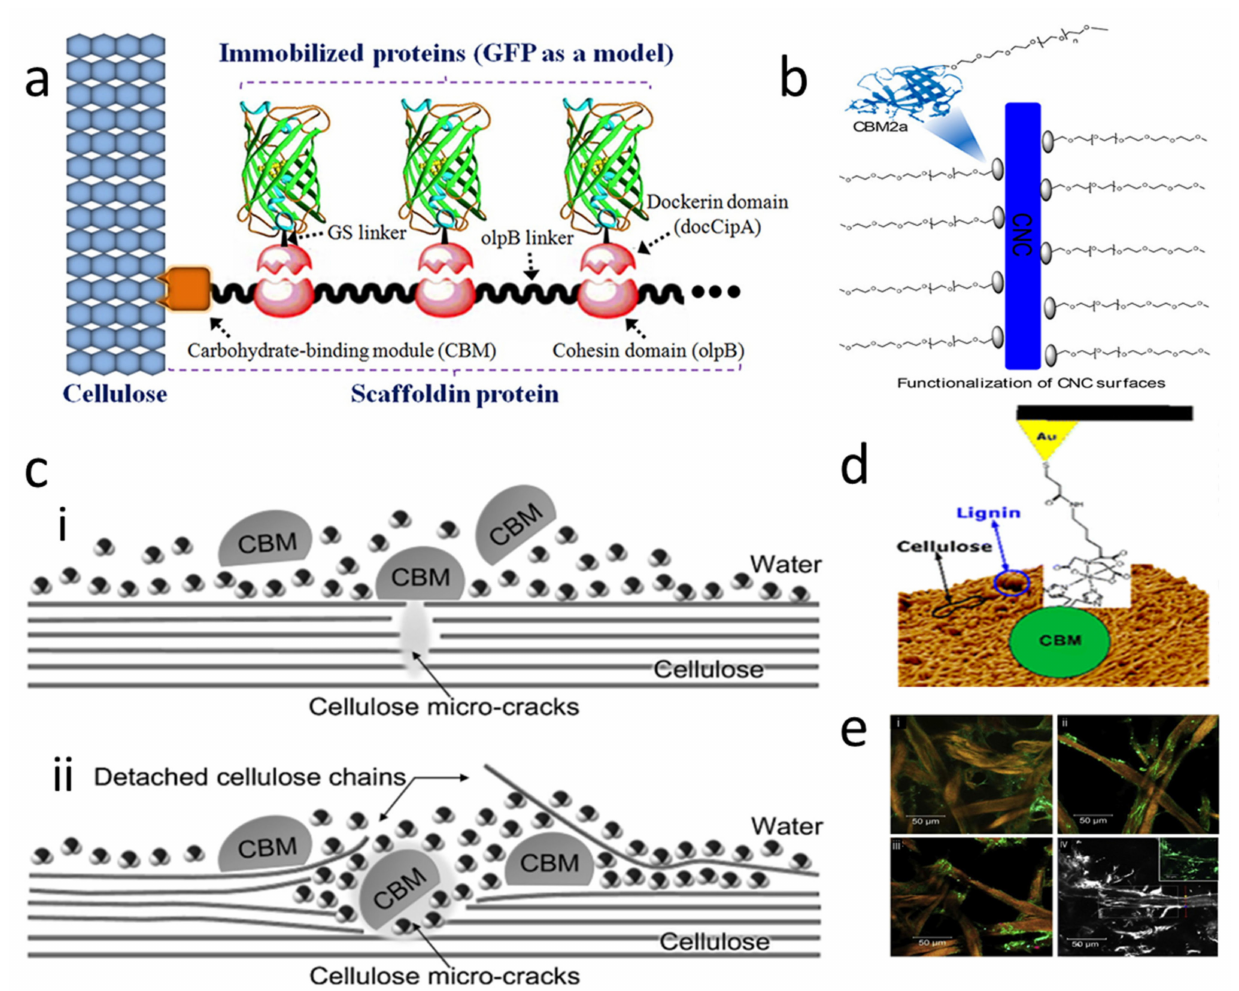
Figure 2. Identification of fibers and substrates by different CBMs. ( a ) Strategies for site-specific and high-loading GFP immobilization on microcrystalline cellulose, reprinted from Ref [81] with permission from American Chemical Society. The GFP − scaffoldin complex could be immobilized on the cellulose surface via CBM − cellulose interaction; ( b ) Schematic representation of a cellulose nanocrystal(CNC) covered with CBM-PEG, reprinted from Ref [87] with permission from American Chemical Society; ( c ) Schematic illustration of morphogenesis of cellulose fibers mediated by CBM1: ( i ) CBM on the surface of cellulose; ( ii ) CBM-promoted amorphization, reprinted from Ref [89] with permission from Elsevier; ( d ) AFM studies different lignin coverage, lignin types of substrates, and the total adhesion of biomass to CBM as a function of surface lignin coverage, reprinted from Ref [95] with permission from American Chemical Society; ( e ) Confocal analysis of interactions between CBMs (labeled with Alexa Fluor 488 C5 Maleimide(Invitrogen)) and filter paper (FP) samples, reprinted from Ref [89] with permission from